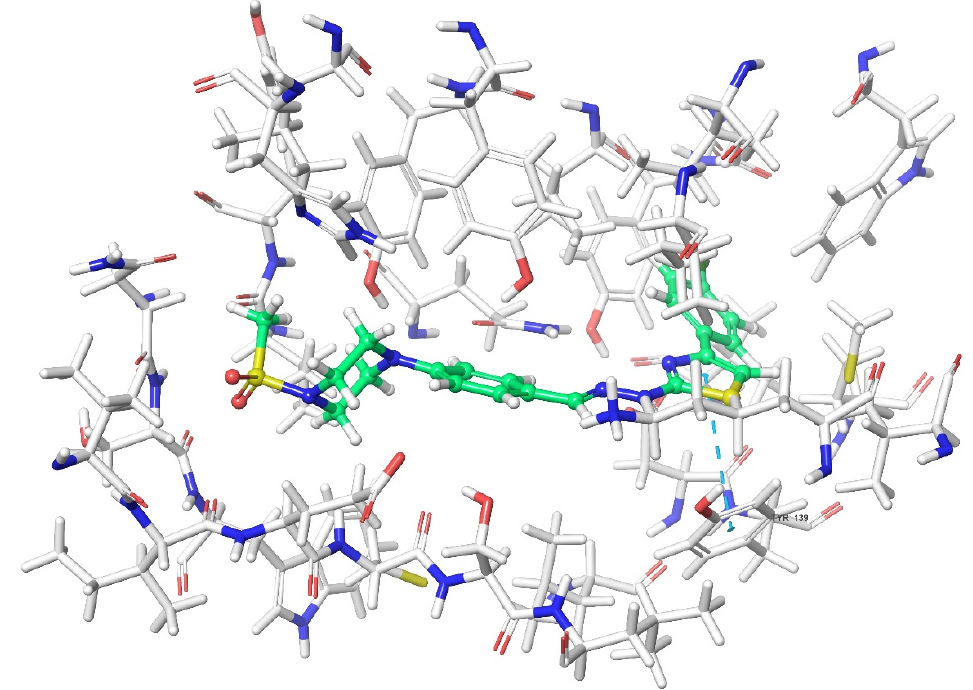
Molecules 2021 , 26 , x FOR PEER REVIEW Figure 23. The two-dimensional interacting mode of compound 3g in the active region of ĸ -opioid receptor (PDB Code: 6B73).